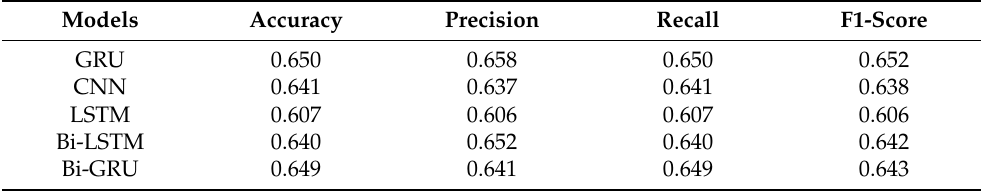
Table 3. Performance comparison of various models trained with combined dataset.